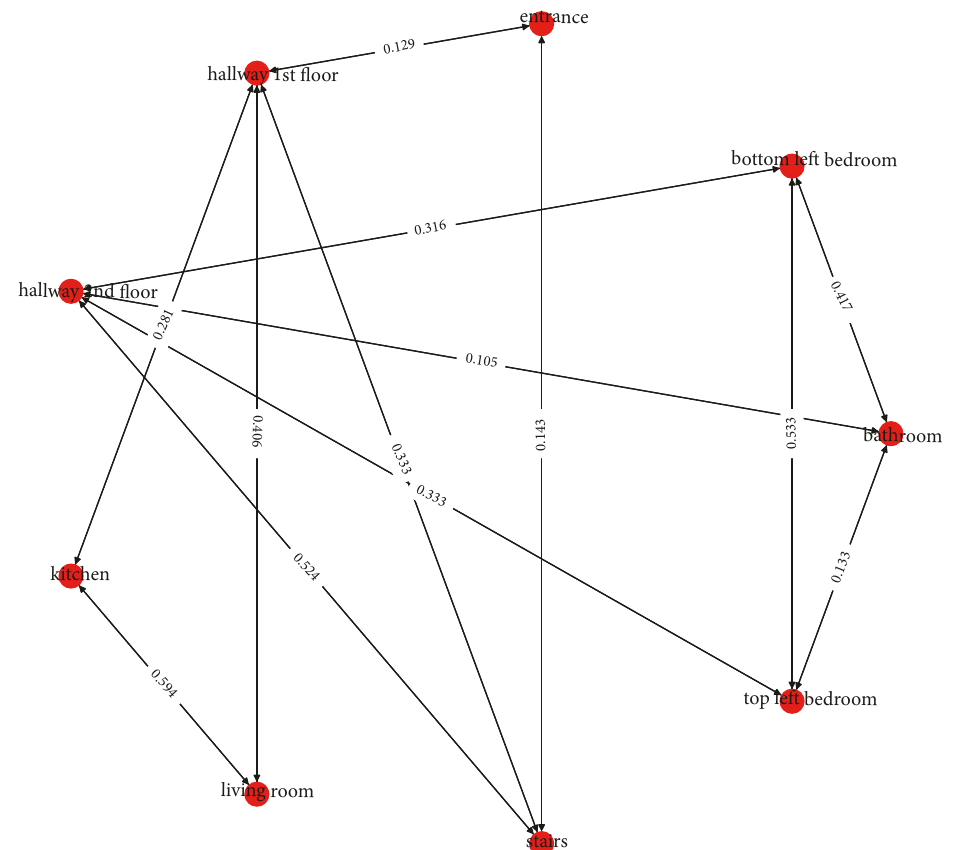
Figure 7: A simplified directed graph after applying the proposed filtering of data.